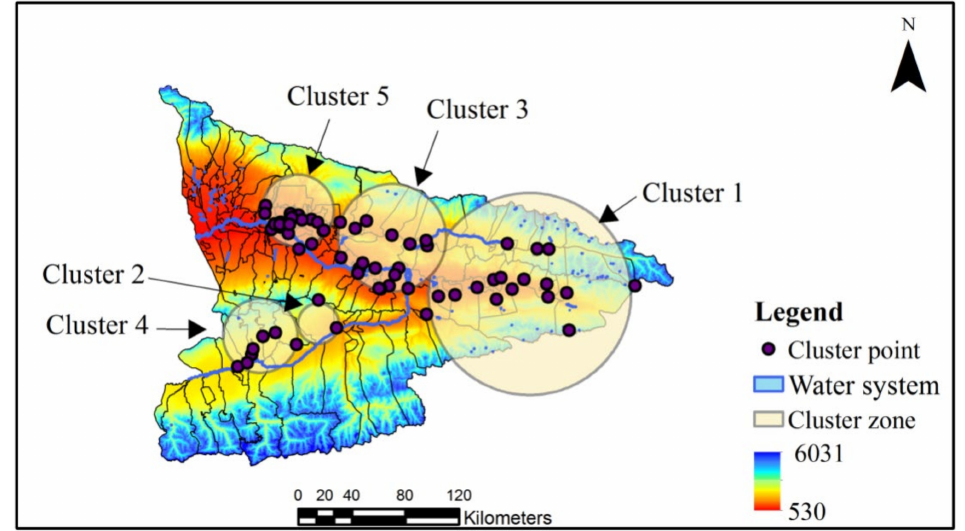
Figure 2. Locations of the space–time clusters in the study